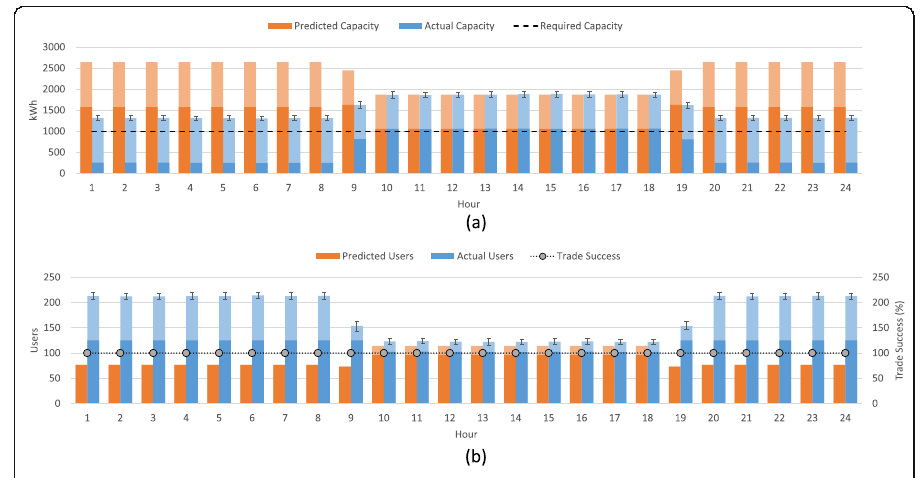
Fig. 10 Results for 100 simulated trades for each hour following learning of changed decision criteria from 60 iterations of the same trade. Description as for Fig. 5 Equation 6 Prediction error given a predicted and actual capacity